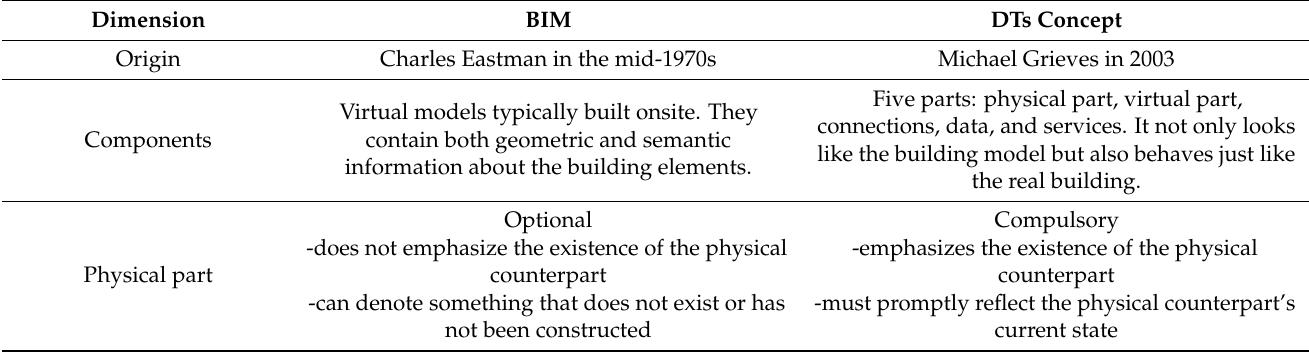
Figure 6. BIM and DTs processes and supporting technologies. Adapted from [61]. Table 2. Detailed comparison of BIM and DTs of buildings, adapted from